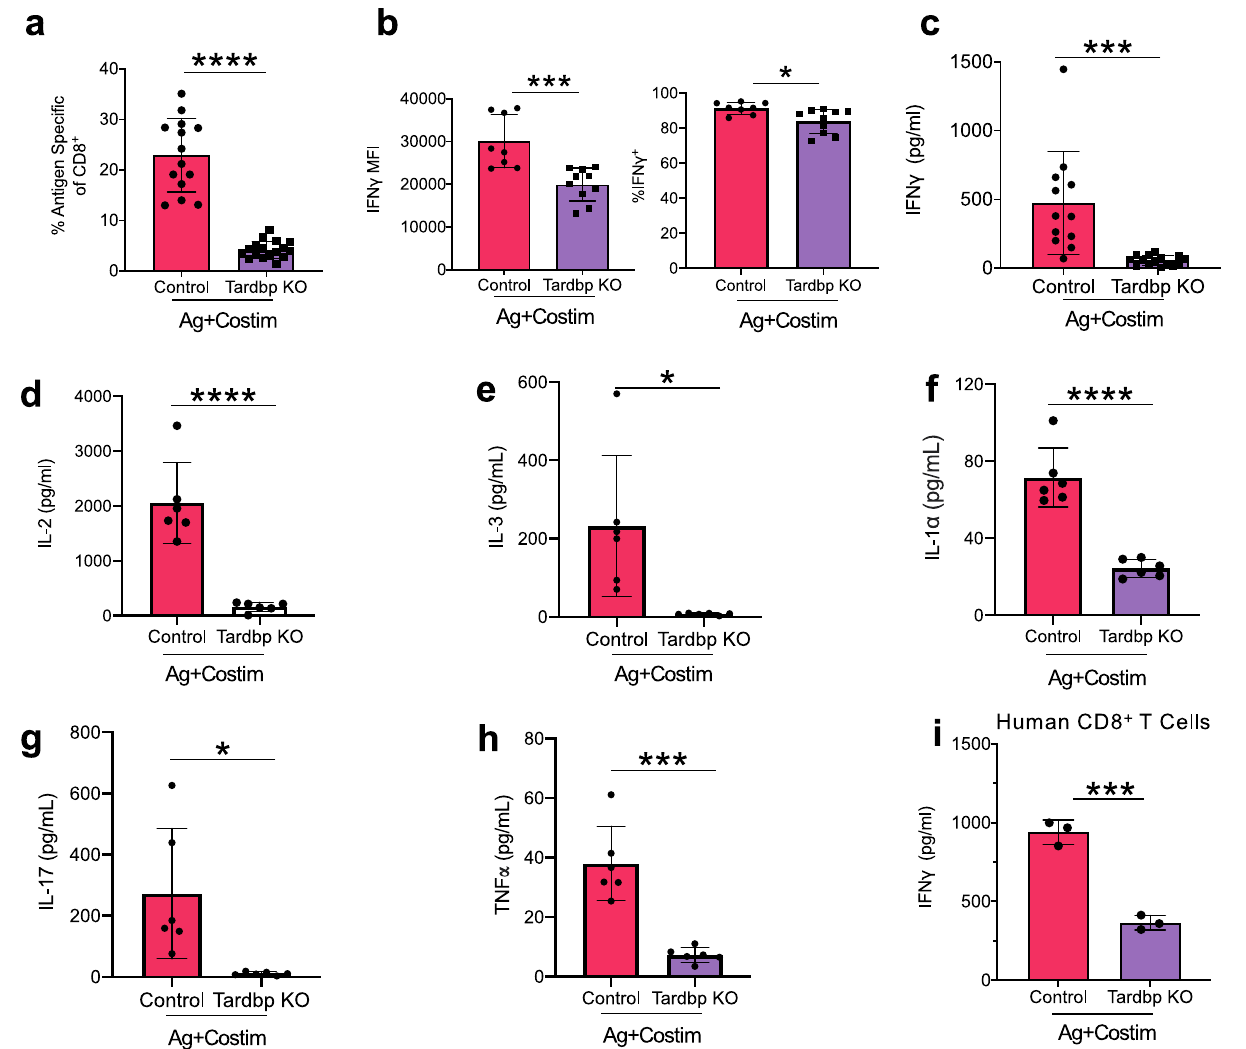
Fig. 6 Optimal effector function of costimulated CD8 + T cells requires Tardbp . a Expansion of antigen speci fi c CD8 + T cells with and without splicing factor Tardbp after costimulation processed as in 4A, n = 14 for Ctrl, n = 17 for Tardbp KO over 3 independent biological replicates. b Intracellular staining for IFN γ after 4 h restimulation with PMAi measured by mean fl uorescence intensity (MFI) (left panel) & percentage of Live, TCR-V α 2 + , TCR-V β 5 + , CD45.1 + , CD8 + T cells that are IFN γ + (right panel) between Ctrl and Tardbp knockout groups, n = 8 for Ctrl, n = 10 for Tardbp KO over three independent biological replicates. c IFN γ levels by ELISA 20 h after restimulation with PMAI between Ctrl and Tardbp KO groups, n = 12 for Ctrl, n = 15 for Tardbp KO, 3 independent biological replicates. d – h In fl ammatory cytokine levels by multiplex ELISA 20 h after restimulation with PMAI between Ctrl and Tardbp KO groups, n = 6 per group. i IFN γ levels by ELISA 20 h after restimulation with PMAi between Ctrl and Tardbp KO groups of human CD8 T cells 4 days after CD3/CD28, n = 3/group, each point is an independent biological replicate. All mouse restimulation experiments were conducted on cells sorted directly ex-vivo. Data are presented as mean values + / − SD using a two-sided t test with Benjamini, Krieger and Yekutieli to control FDR where * represents n digits after decimal for p value. Source data are provided as a Source Data fi